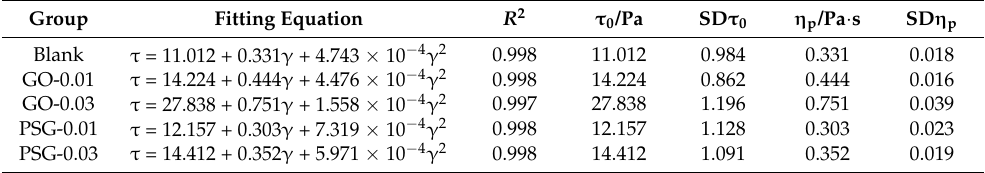
Table 5. Fitting result of M–B Model parameters.